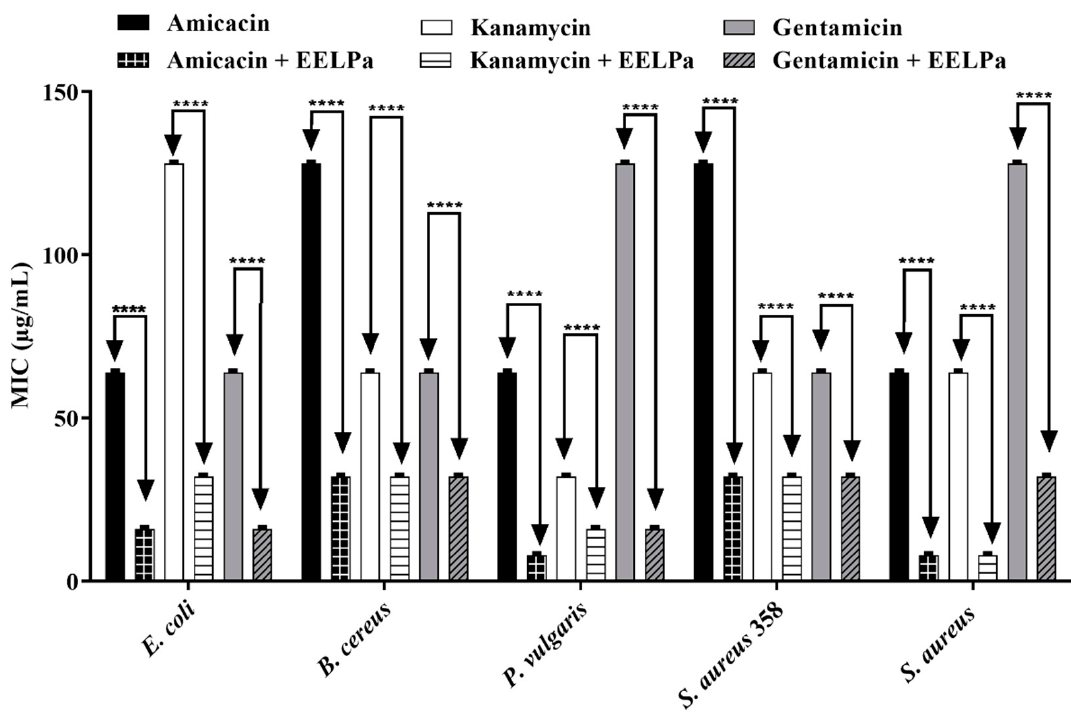
Figure 2. Modulating effect of ethanol extract of fresh P. amboinicus leaves on the antibiotic activity of amikacin, kanamycin and gentamicin against E. coli , B. cereus , P. vulgaris , S. aureus 358 and S. aureus strains. ****: p < 0.0001 (ANOVA and Tukey’s test).